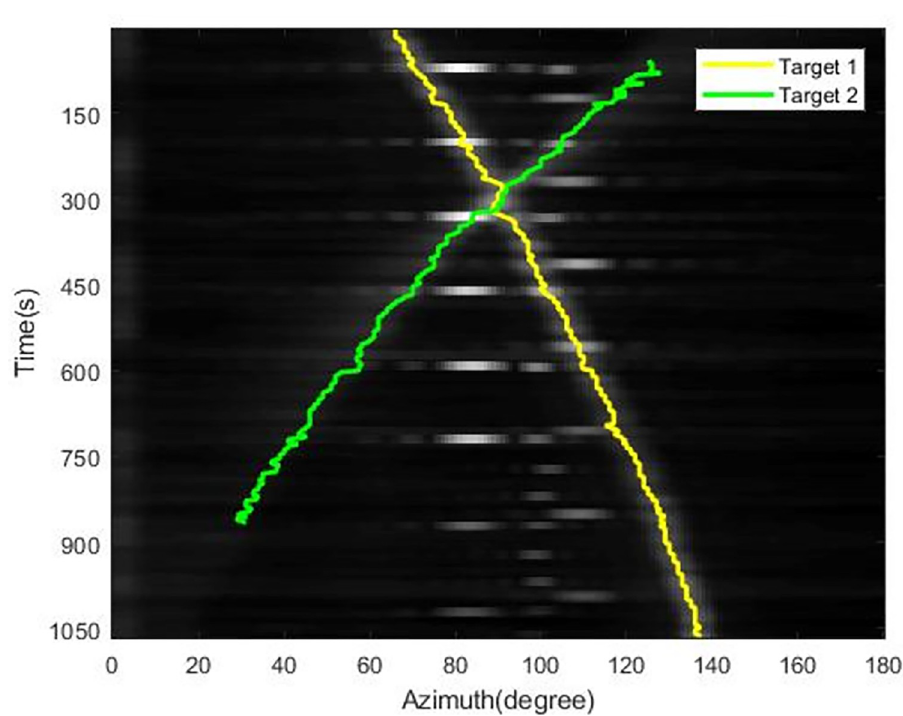
Fig 24. The tracking results of the MLDE method successfully identify the target where the two azimuth trajectories cross.